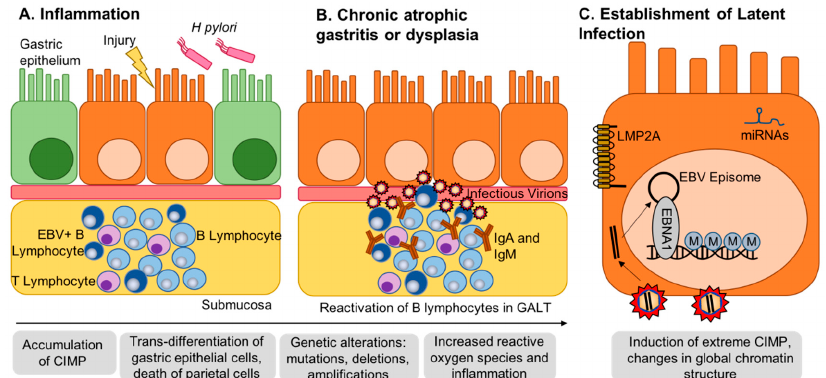
Figure 3. Gastritis-infection-cancer sequence of EBV-associated gastric cancer. ( A ) Local inflammation can be caused by numerous factors, including H. pylori infection or local injury. Prolonged inflammation results in chronic gastritis and the recruitment of lymphocytes to gut-associated lymphoid tissue (GALT) within the submucosa. ( B ) Chronic gastritis can progress into intestinal metaplasia or dysplasia characterized by the accumulation of CpG-island hypermethylator phenotype (CIMP) and the trans-differentiation of mature gastric epithelial cells. EBV-infected B lymphocytes reactivate to produce infectious virions with access to the basolateral surface of the epithelial cells. Normal B lymphocytes may additionally reactivate and produce IgA and IgM, which have been shown to mediate EBV attachment to epithelial cells. ( C ) EBV enters and establishes latent infection in epithelial cells. EBV latent proteins and miRNAs regulate methylation factors and induce de novo methylation in the host genome driving transformation.